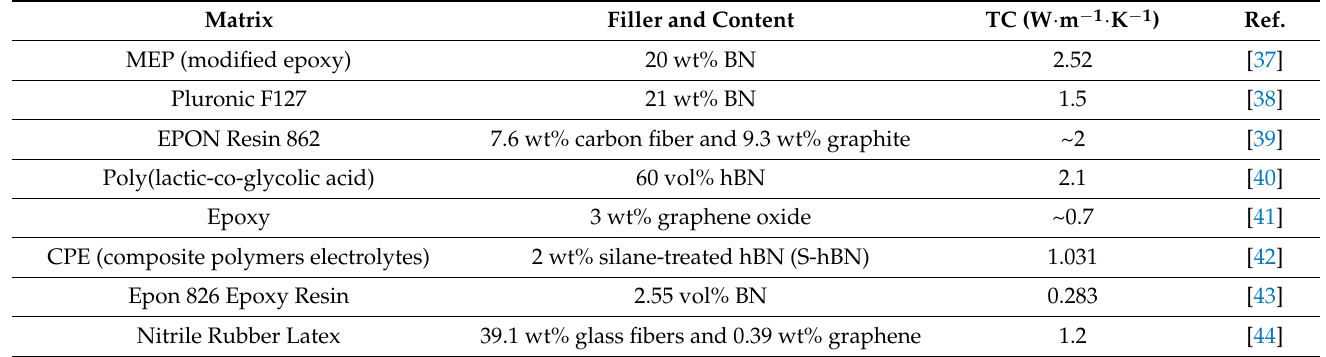
Table 1. Summary of thermally conductive composites prepared by